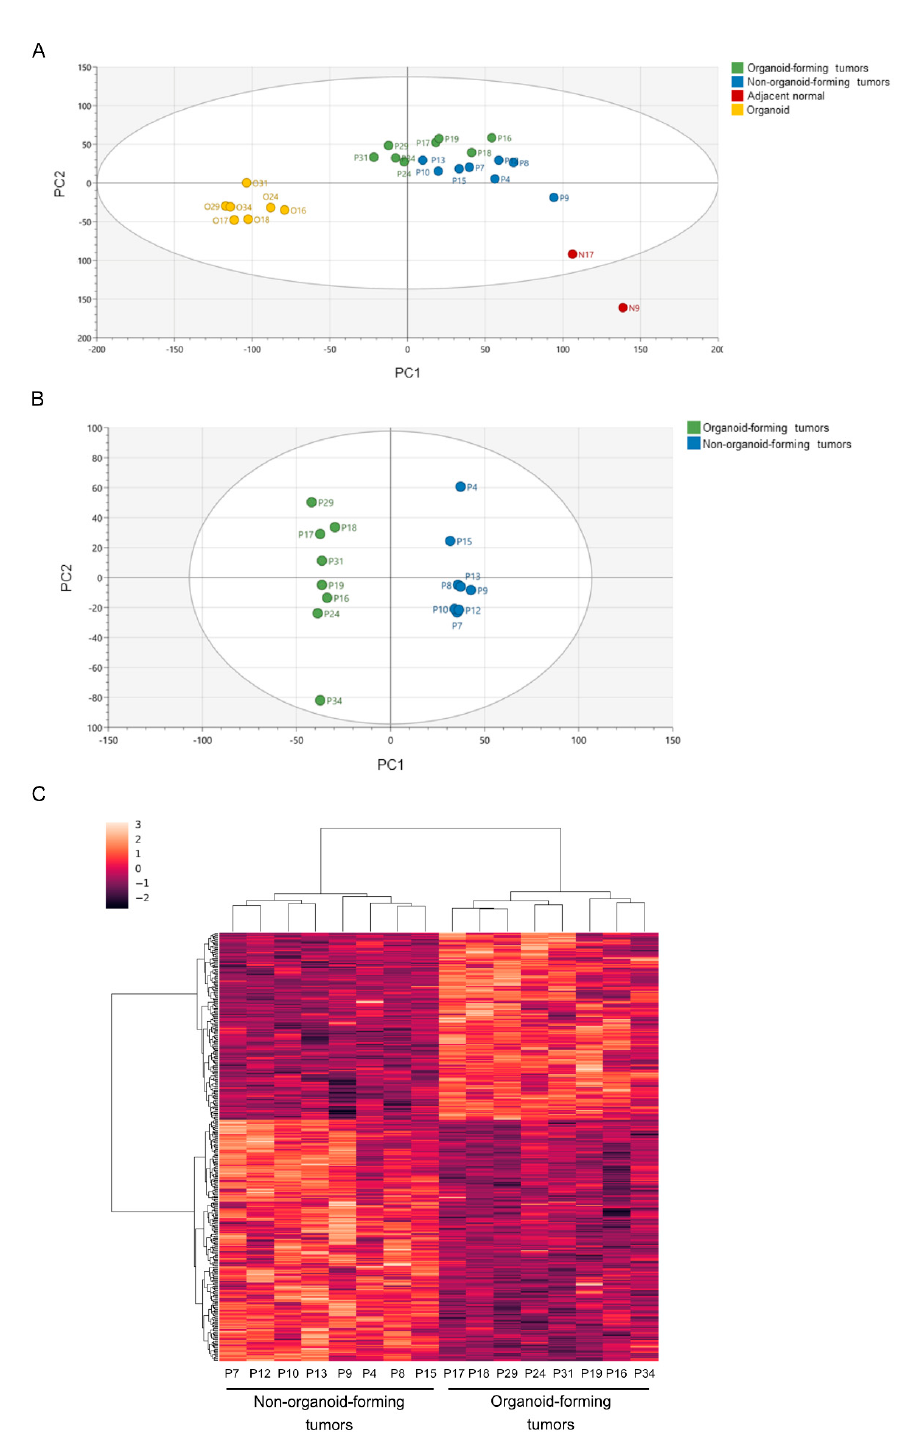
Figure 3. RNA sequencing analysis using primary tumors, organoids and tumor adjacent normal tissues. ( A ) OPLS-DA model of sequenced samples represent score scatter plots distinguishing organoid-forming tumors and non-organoid-forming tumors (P), adjacent normal tissues (N), and organoid samples (O); PCA plot of organoid-forming tumors and non-organoid-forming tumors ( B ) based on di ff erentially-expressed genes between the two groups, as shown in a heat map ( C ). Of the 111 enriched genes in organoid-forming tumors, four genes were found to be involved in stem cell proliferation. LGR6 (leucine rich repeat containing G protein-coupled receptor 6) has